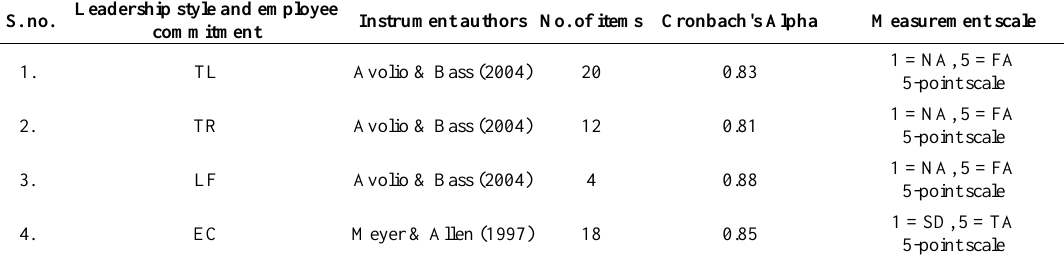
Table 1. Questionnaire design and structure